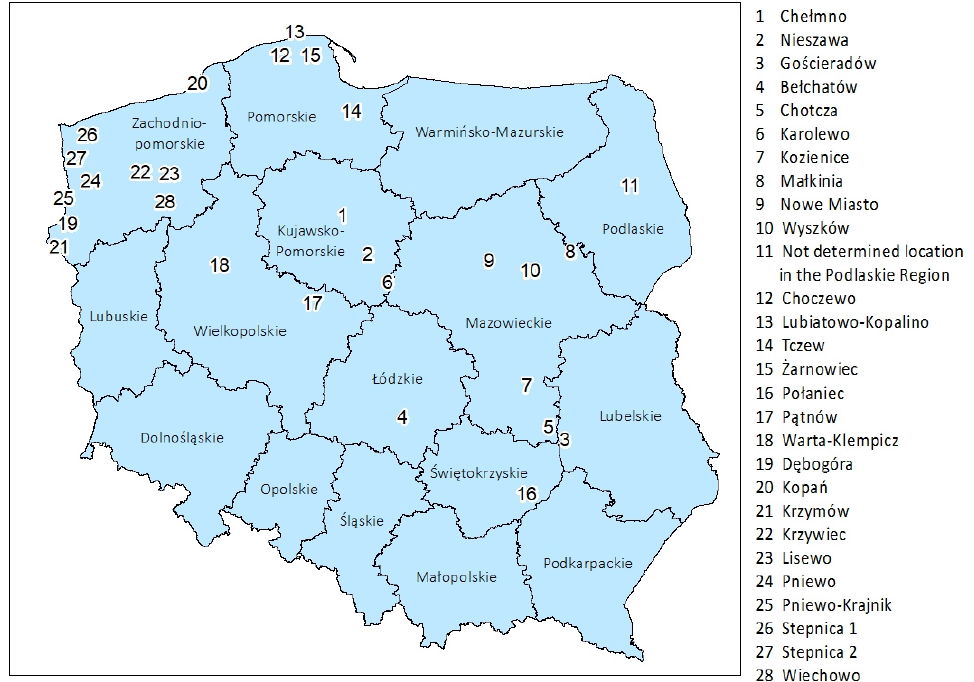
Figure 3. Potential locations of nuclear power plants in Poland. Source: [44].